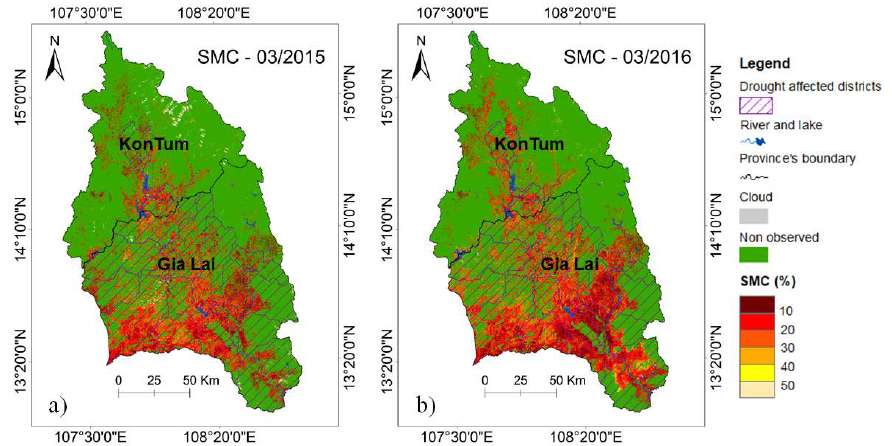
Figure 9. Maps of SMC estimated from the L8 images acquired over the northern part of the Central Highlands of Vietnam in March 2015 ( a ) and March 2016 ( b ), showing that almost all of the observed land areas were covered by soils with SMC < 40%, which nearly fit the drought-affected districts reported by the local government and management (the oblique lined pattern areas).